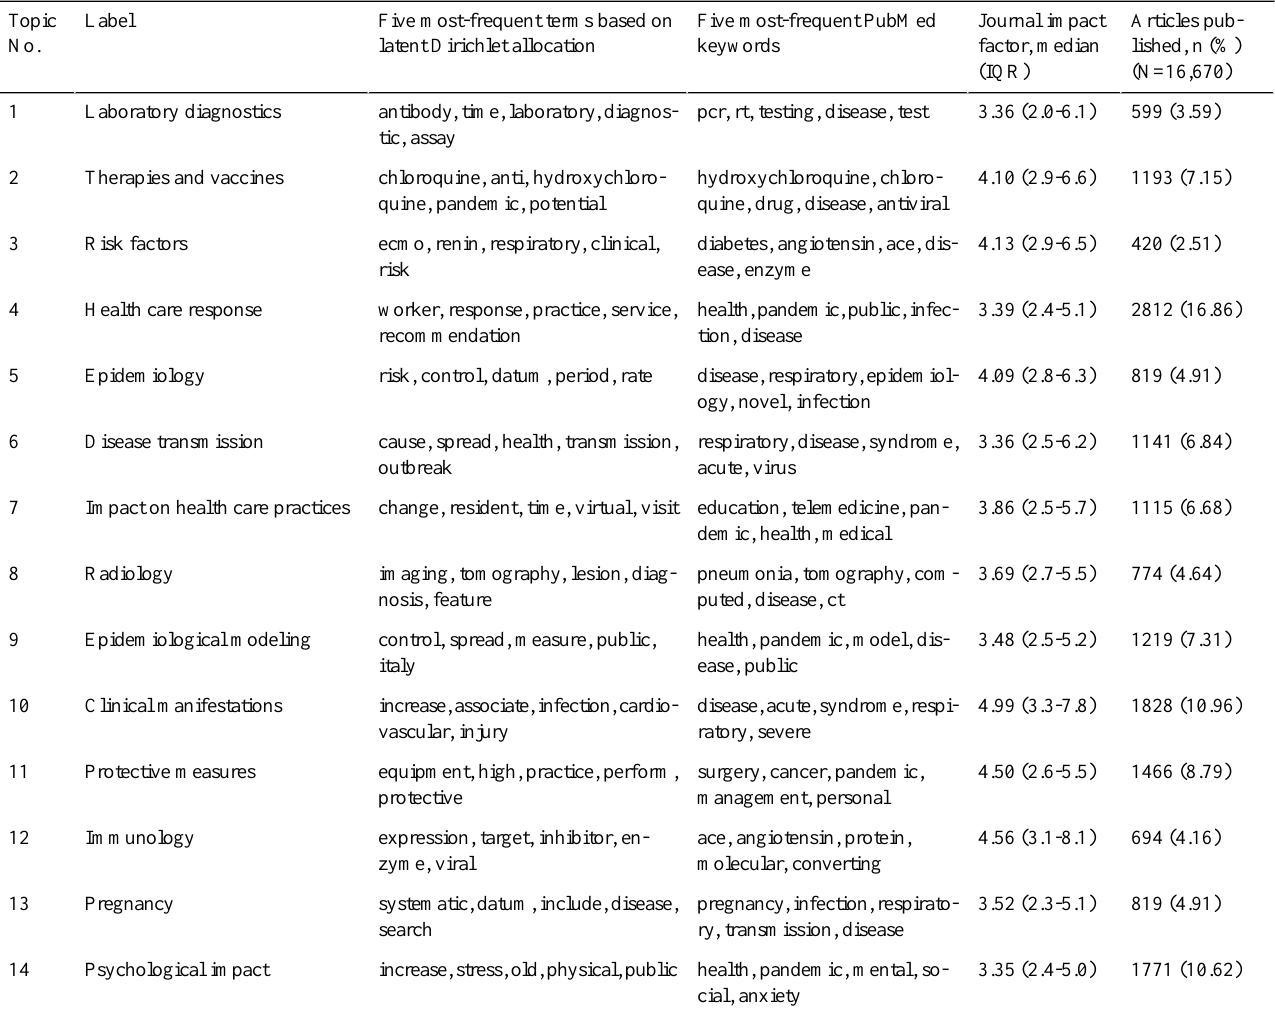
Table 1. COVID-19 topics from latent Dirichlet allocation